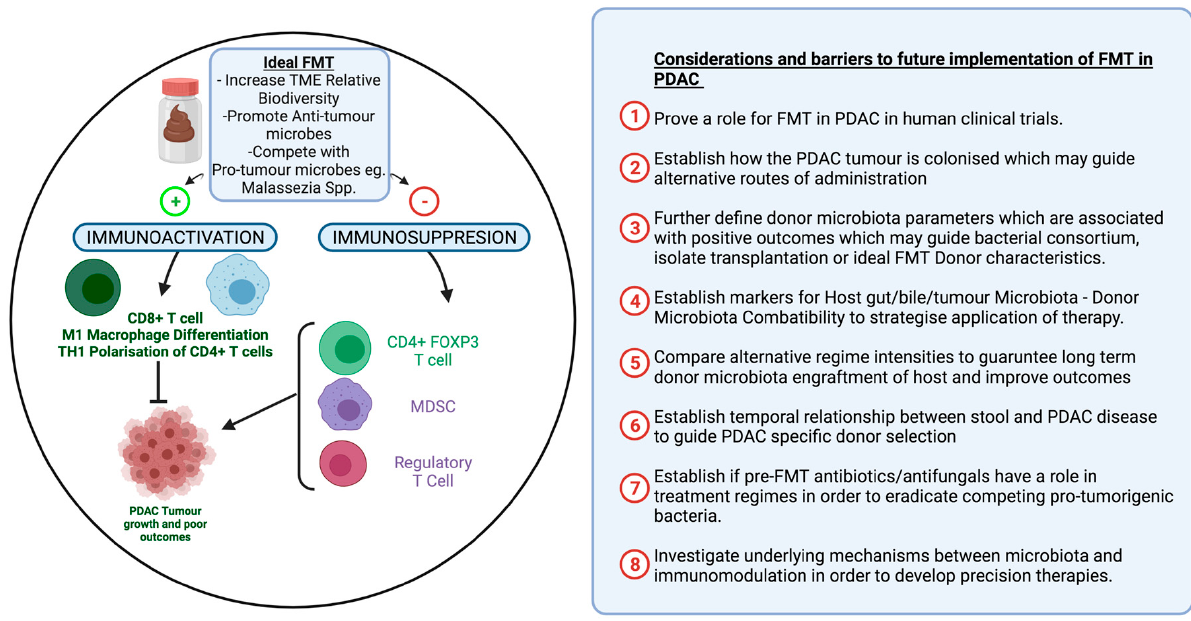
Figure 4. The ideal FMT must have a composition which promotes immunoactivation and inhibits immunosuppression within the TME ( left ). Current considerations and barriers to FMT implementation in PDAC are highlighted ( right ).